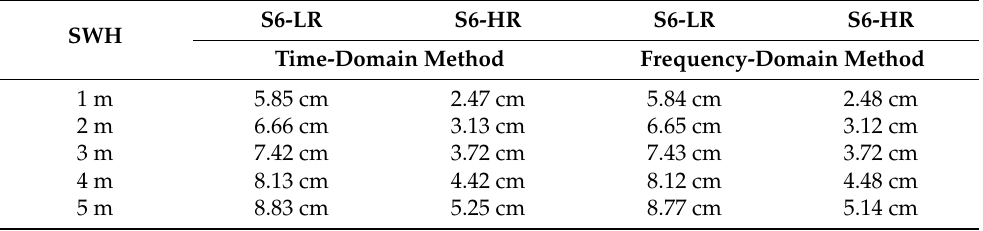
Table 4. The 20 Hz noise levels of Sentinel-6 (S6) estimated by time- and frequency-domain methods. S6-LR SWH